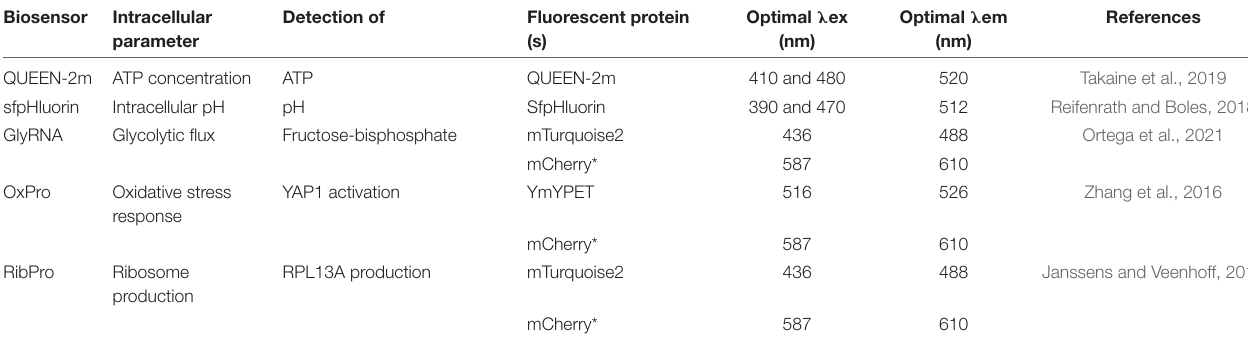
TABLE 1 | Summary of biosensors in the toolbox.